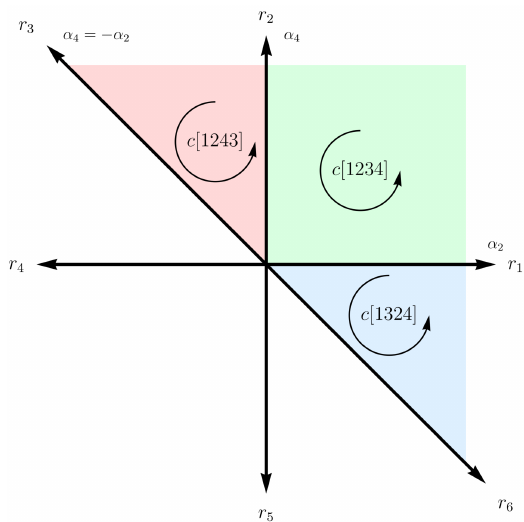
Figure 7 . The three positive sectors c [1234] , c [1324] , c [1243] appearing in the U(1) decoupling relation